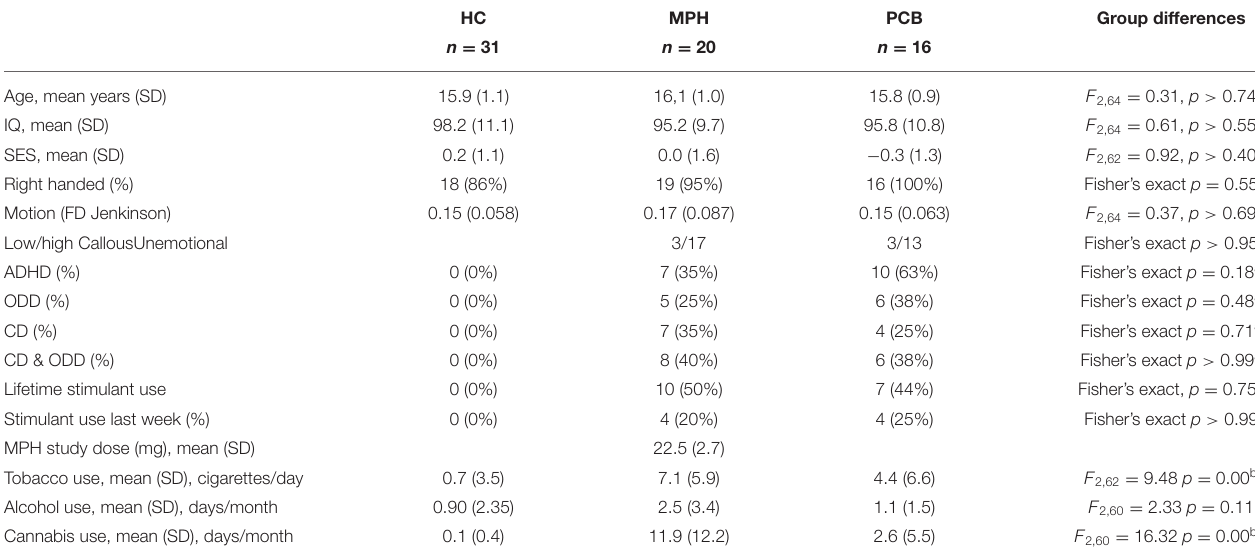
TABLE 1 | Characteristics of the HC and DBD groups.